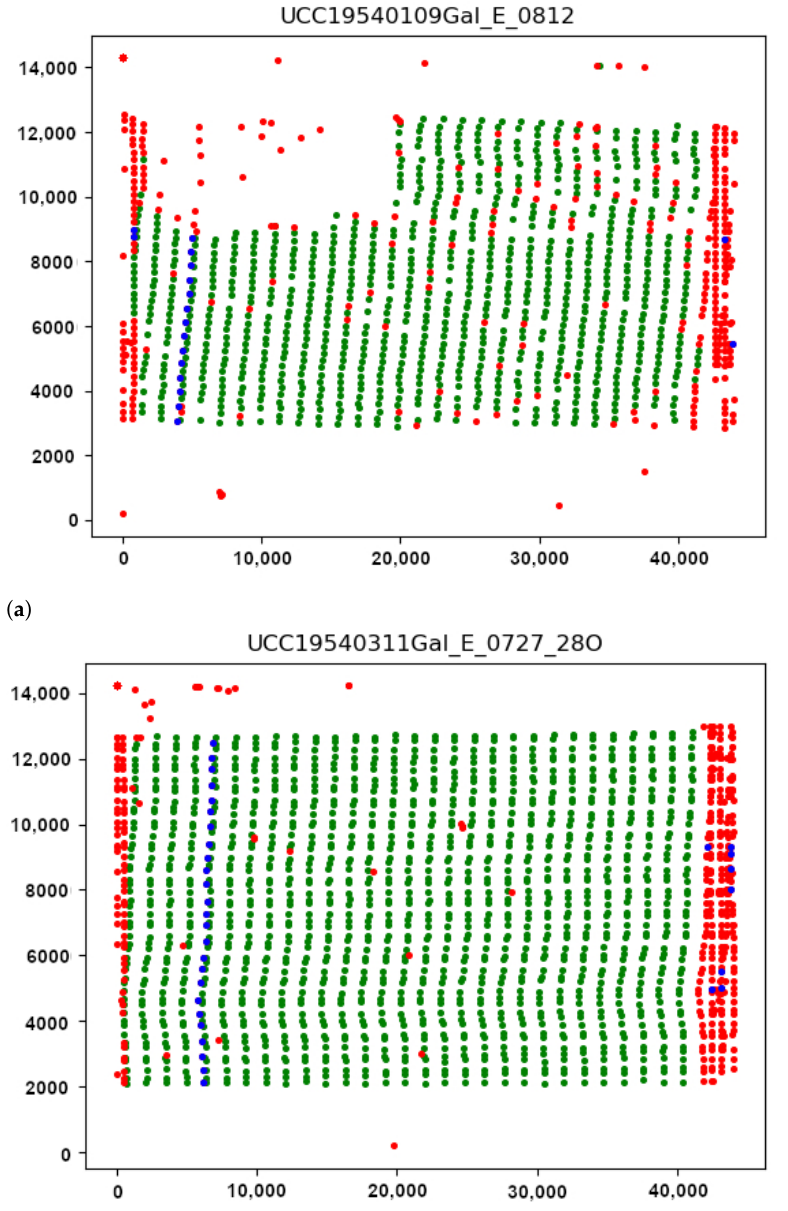
Figure 20. Controlling digitising results using Python (Matplotlib library). ( a ) Quality control for time gaps: missed marks in unrecognised segments. ( b ) Correctly identified time gaps controlled by Python’s Matplotlib. Different color dots are used to separate minute marks (green), hour marks (blue) and margin values and outliers